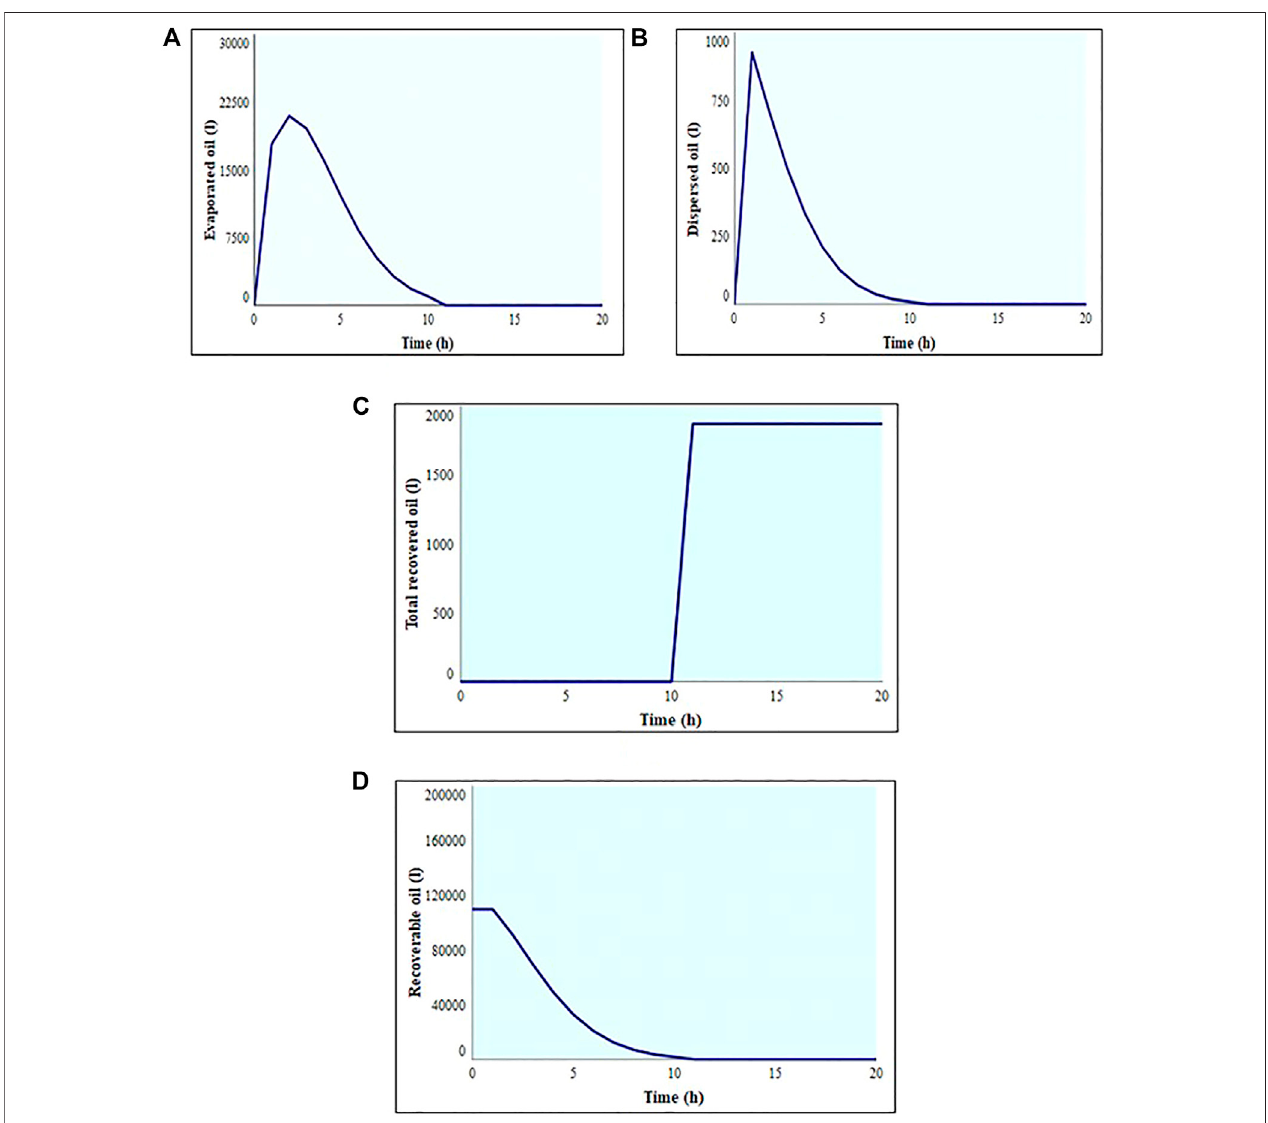
FIGURE 2 | Modeling of (A) oil evaporation, (B) oil dispersion, (C) total recovered oil volume, and (D) recoverable oil as the function of time.